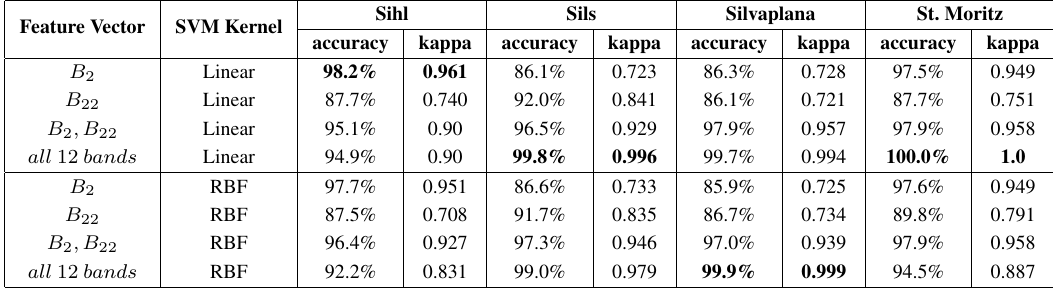
Table 9: MODIS results on the combined data from both winter 2011 - 12 and winter 2016 - 17